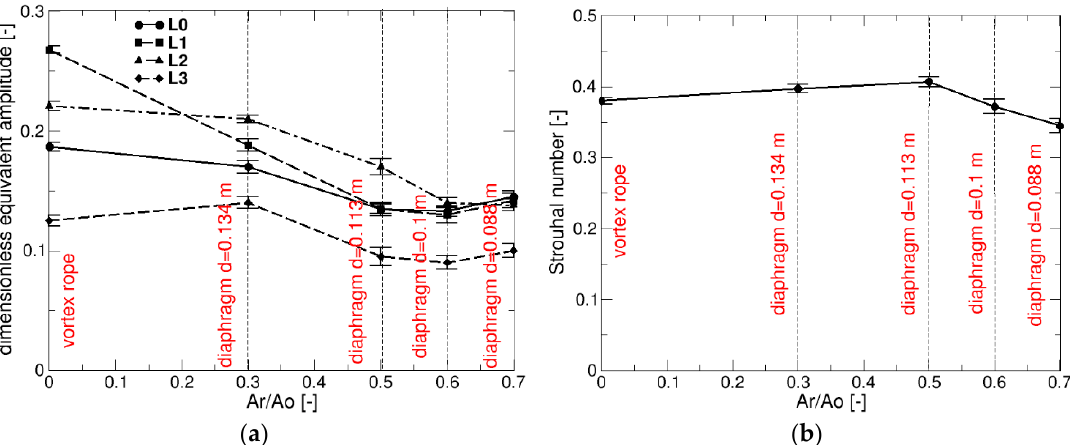
Figure 7. Global dimensionless equivalent amplitude ( a ) and Strouhal number ( b ) versus shutter area from the outlet test section.